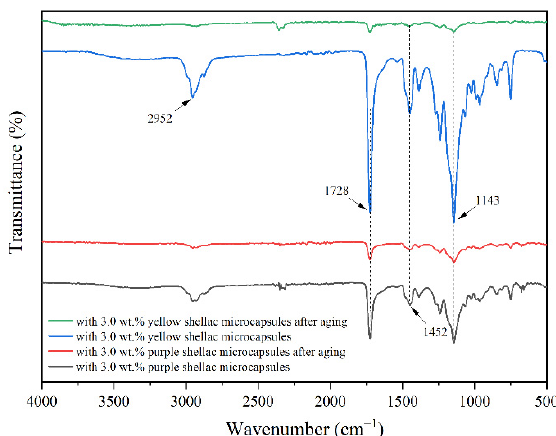
Figure 7. FTIR of the coatings with and without transparent shellac microcapsule before and after aging.